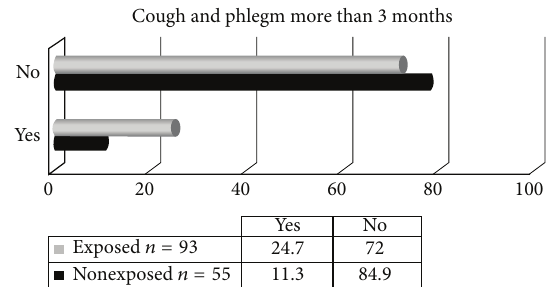
Figure 1: Cough and phlegm more than 3 months among subjects.